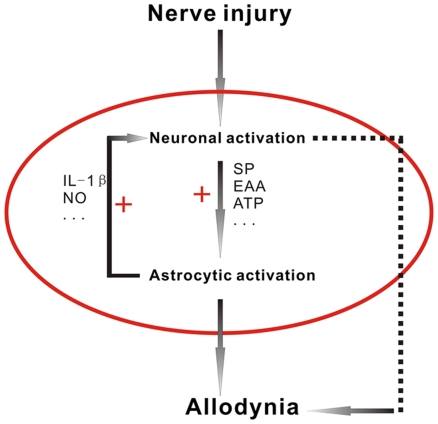
Schematic illustration of the positive feedback circuit between spinal neurons and astrocytes in neuropathic pain state.After peripheral nerve injury, various transmitters like substance P (SP), excitatory amino acids (EAA), were released from the presynaptic terminals in the superficial dorsal horn, which caused immediate (in hours) neuronal activation in the spinal dorsal horn. Neuronal activation is followed by a higher degree of synthesis and release of excitatory transmitters, which triggered late (>3 d) astrocytic activation. Activated astrocytes also produced neuroexcitatory substances, like IL-1β, IL-6, NO, and so on. These neuroexcitatory substances could action back to modify neuronal behavior, contributing to pain facilitation.